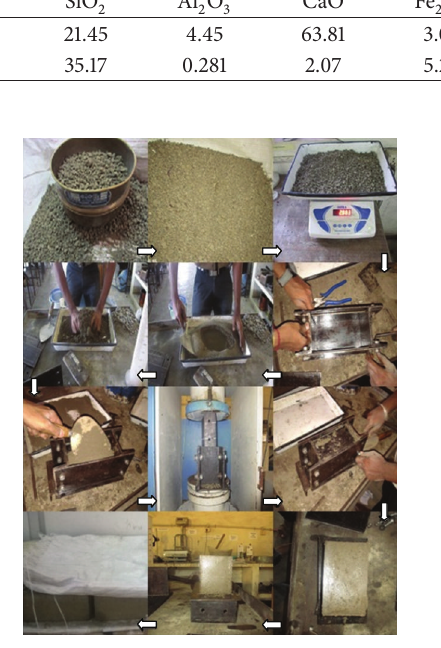
Figure 2: Graphical description of casting and curing of stabilized earth blocks.